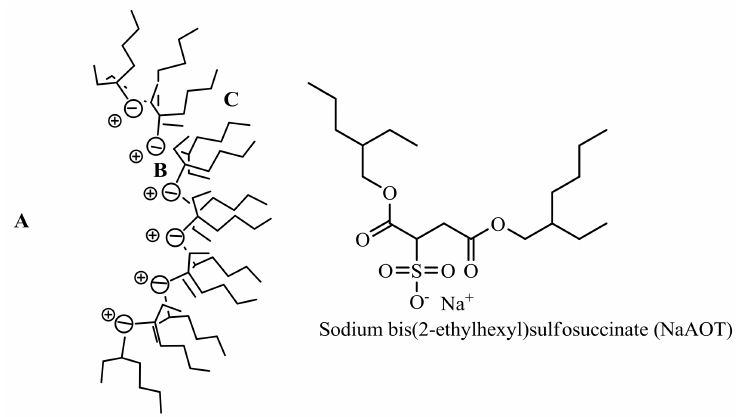
Scheme 1. The structures of the reverse micellar interface of a NaAOT reverse micelle (RM) with three different specific locations for additives. Labels A, B, and C shown are in the aqueous core, interfacial region, and hydrophobic part of the nanostructure, respectively. ( left ) and the structure of NaAOT ( right